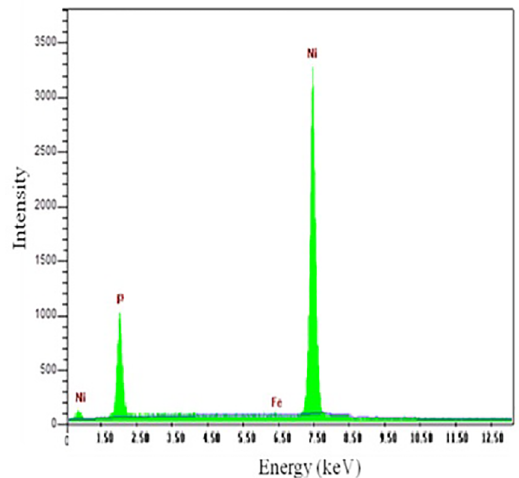
Figure 2. EDS analysis of Ni-P